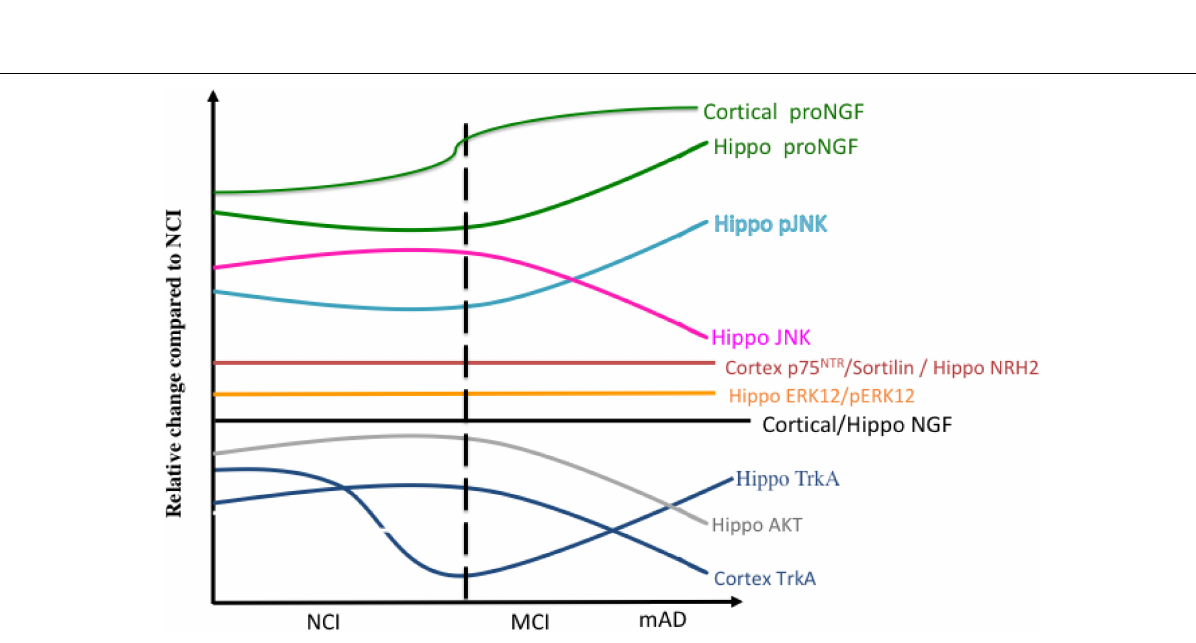
Frontiers in Neuroscience |